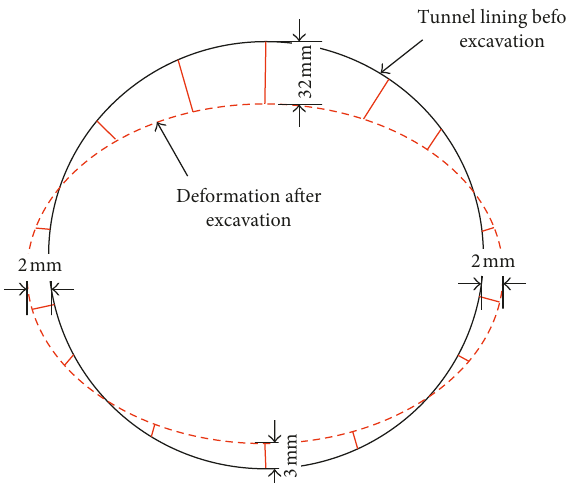
Figure 9: Deformation distribution of tunnel lining after water